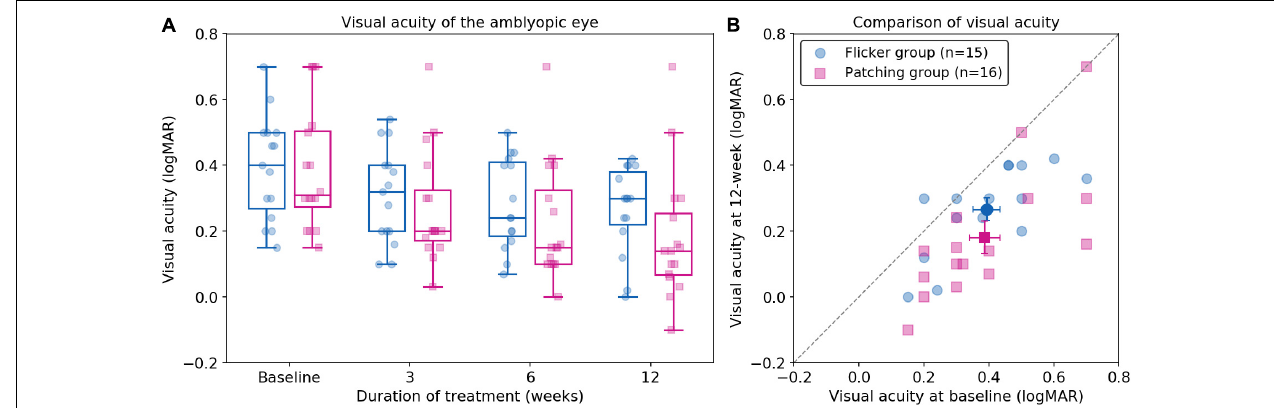
FIGURE 2 | Best-corrected visual acuity following treatment. (A) Boxplots of best correct visual acuity (BCVA) of the amblyopic eye (in logMAR) in Flicker and Patching treatment groups. Blue represents the Flicker Group, and pink the Patching Group. Individual data point is represented by a dot. The black solid line within each box represents the median. The box represents the interquartile range (IQR) of the data (25th to 75th percentile). The whisker represents 1.5 × IQR either above the third quartile or below the first quartile. (B) Individual data point of visual acuity (BCVA) in patients’ amblyopic eyes measured at baseline and at 12 weeks of treatment. The dashed line represents unity. Blue circles represent the Flicker Group, whereas pink triangles represent the Patching Group. Points below the dashed line (unity line) show an improved BCVA at week 12 relative to baseline.